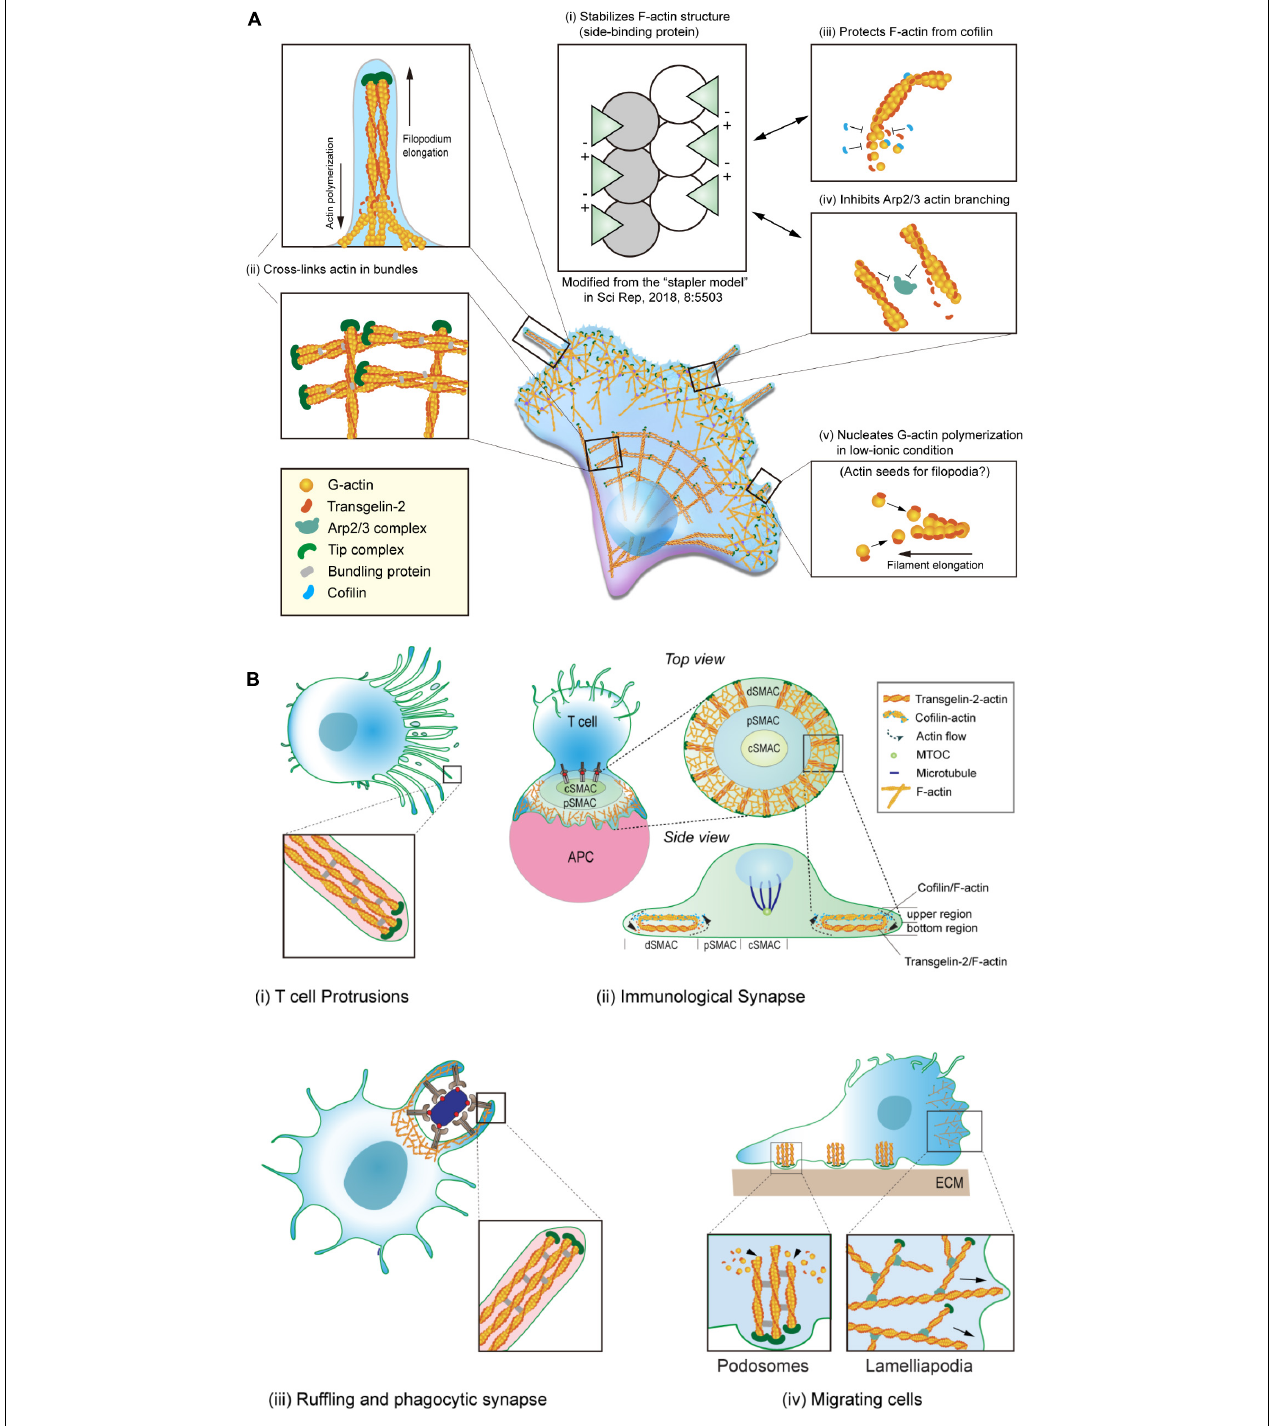
FIGURE 2 | Biochemical properties cellular localization of transgelin-2. (A) Biochemical properties of transgelin-2. Transgelin-2 directly binds to F-actin and stabilizes its structure (i) (Kim H.-R. et al., 2018). Transgelin-2 cross-links actin in bundles (ii) (Na et al., 2015; Kim H.-R. et al., 2018). It also acts as a side-binding protein and stabilizes F-actin (ii). This property is important to protect F-actin from cofilin-mediated depolymerization (iii) and to compete with Arp2/3 complex-mediated actin branching (iv) (Kim H.-R. et al., 2018). Transgelin-2 also can polymerize G-actin in low-ionic conditions, in which actin polymerization is prohibited (Kim H.-R. et al., 2018). (B) Localization of transgelin-2 in immune cells. Transgelin-2 is localized at the membrane-protrusive regions of T cells during antigen-recognition on antigen-presenting cells (APCs) (i). It also is located at the distal-supramolecular activation cluster (d-SMAC) area in mature immune synapse (ii). In professional phagocytes, this protein is enriched at the phagocytic cup or phagocytic synapse (iii). In dynamically moving cells, transgelin-2 localizes at the filopodial tips and podosomes (iv).